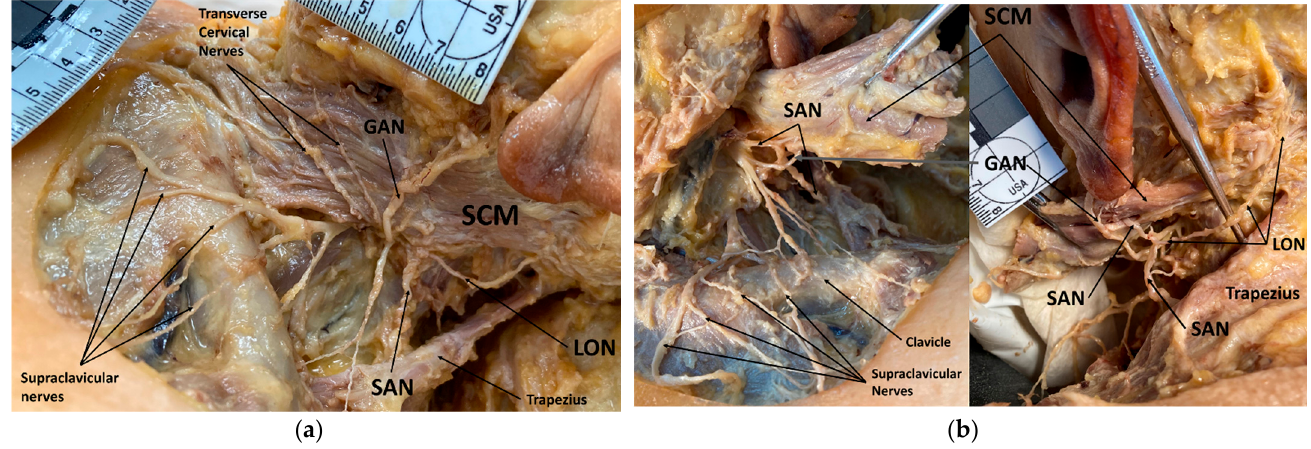
Figure 3. Cadaveric photo of left cervical and auricular regions showing variant with spinal acces- sory nerve (SAN) sending a small branch to join the lesser occipital nerve (LON): Superficial view ( a ) and deep view ( b ). Abbreviations: GAN = great auricular nerve; LON = lesser occipital nerve; SAN = spinal accessory nerve (CN XI); SCM = sternocleidomastoid.